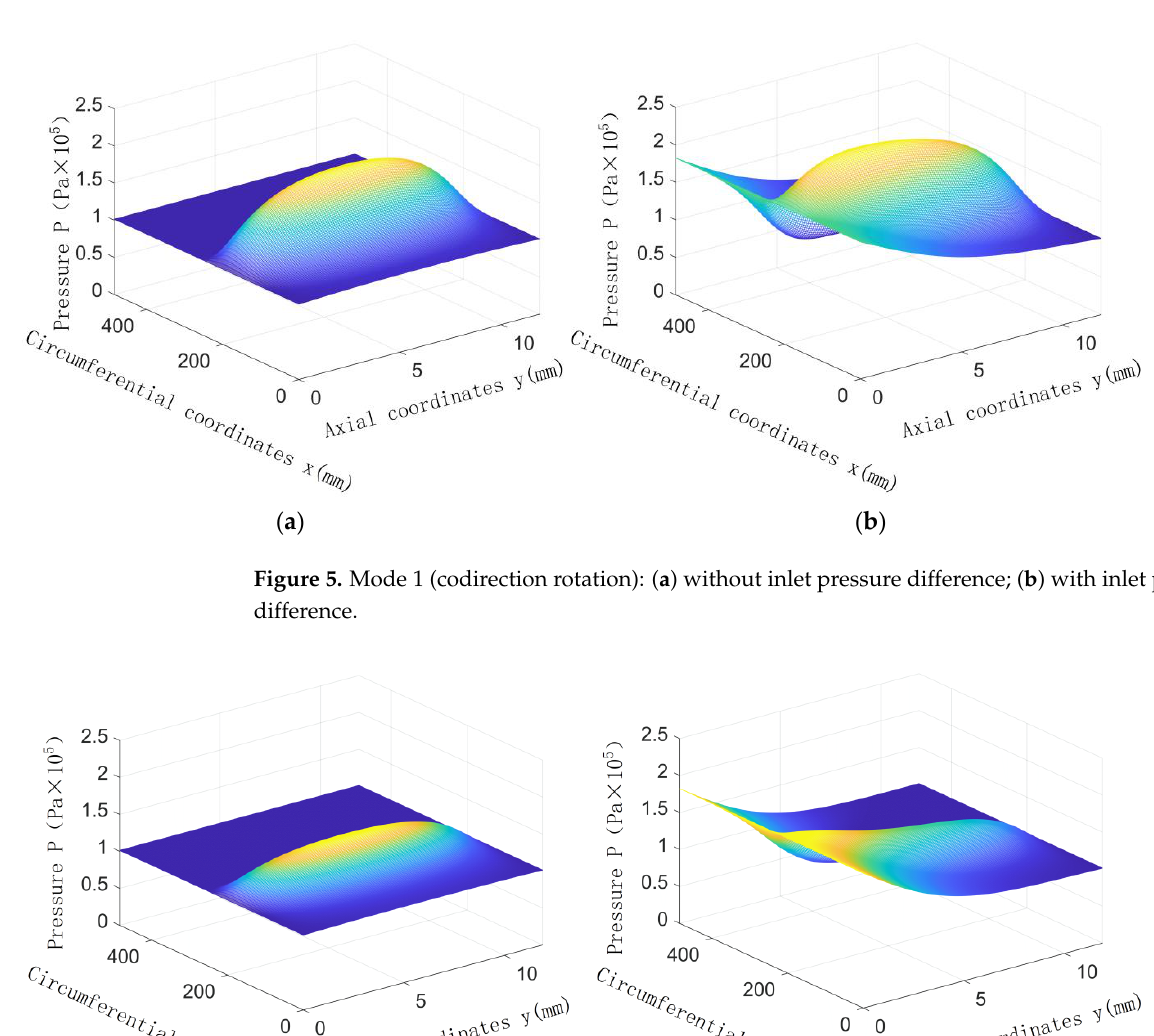
( b ) Figure 7. Mode 3 (counter-rotation): ( a ) without inlet pressure difference; ( b ) with inlet pressure difference.